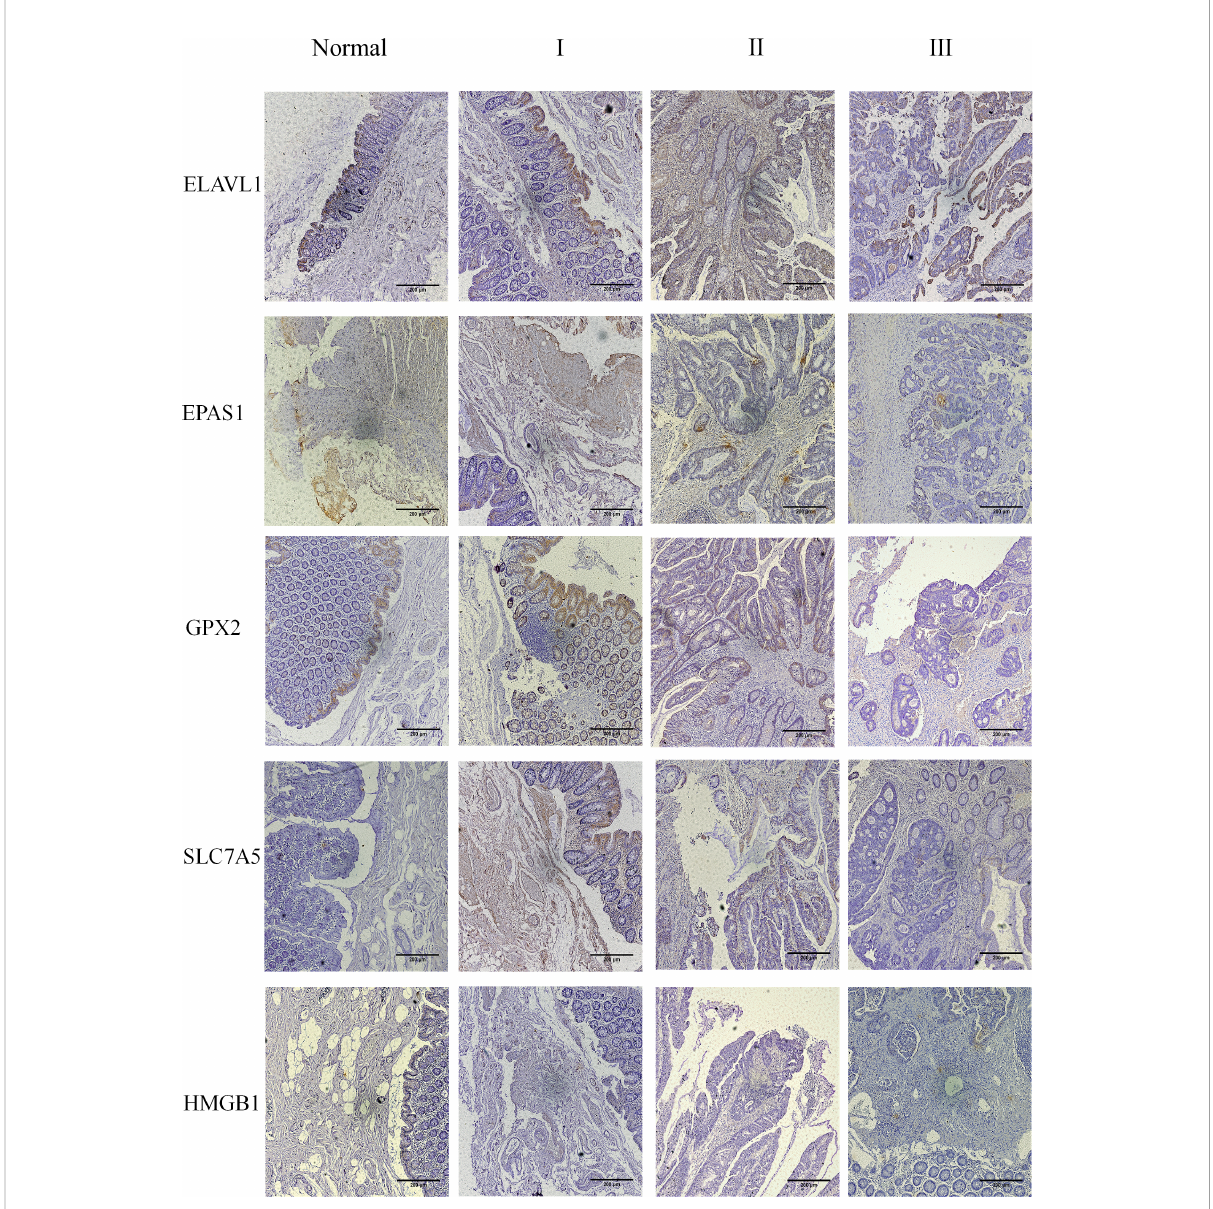
FIGURE 9 The fi ve core genes were expressed in the tumor tissues of stage I – III. Clinical tissue samples were grouped in normal and tumor tissues (stage I – III), and the expression of the fi ve key genes in the clinical samples was observed at multiples of